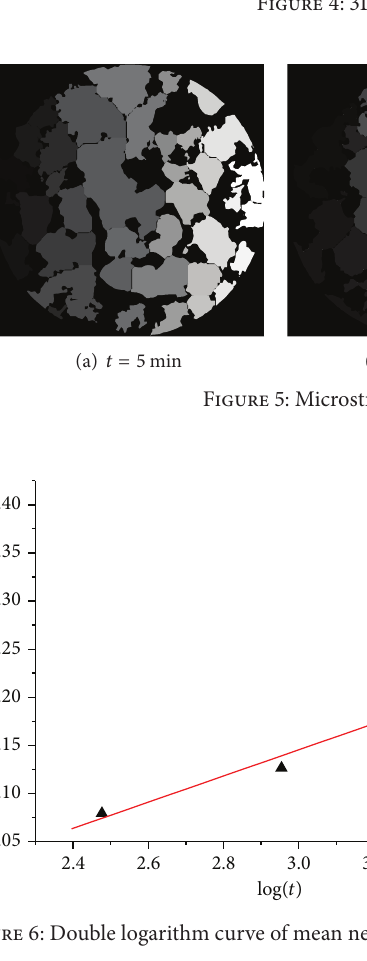
Figure 4: 3D images of the microstructure at different sintering times.